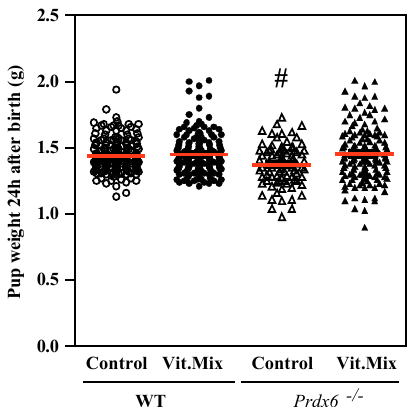
Figure 2. Pup weight at 24 h after birth. Each circle or triangle corresponds to one litter from WT or Prdx6 − / − males, respectively. Open symbols correspond to males fed with the control diet, and black symbols correspond to males fed with the Vit. Mix diet. The mjedian of each group is represented by a horizontal red line. # means smaller than all the other groups ( p ≤ 0.05, two-way ANOVA and Tukey tests).